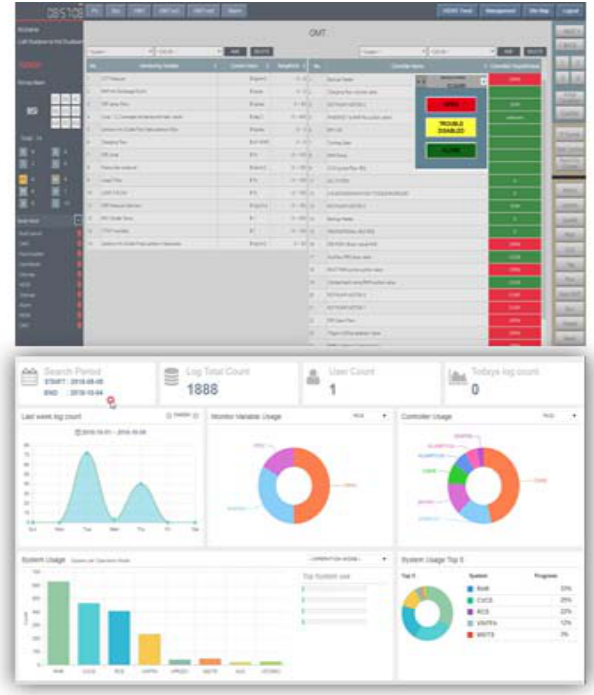
Fig.10. Display Design Examples of the